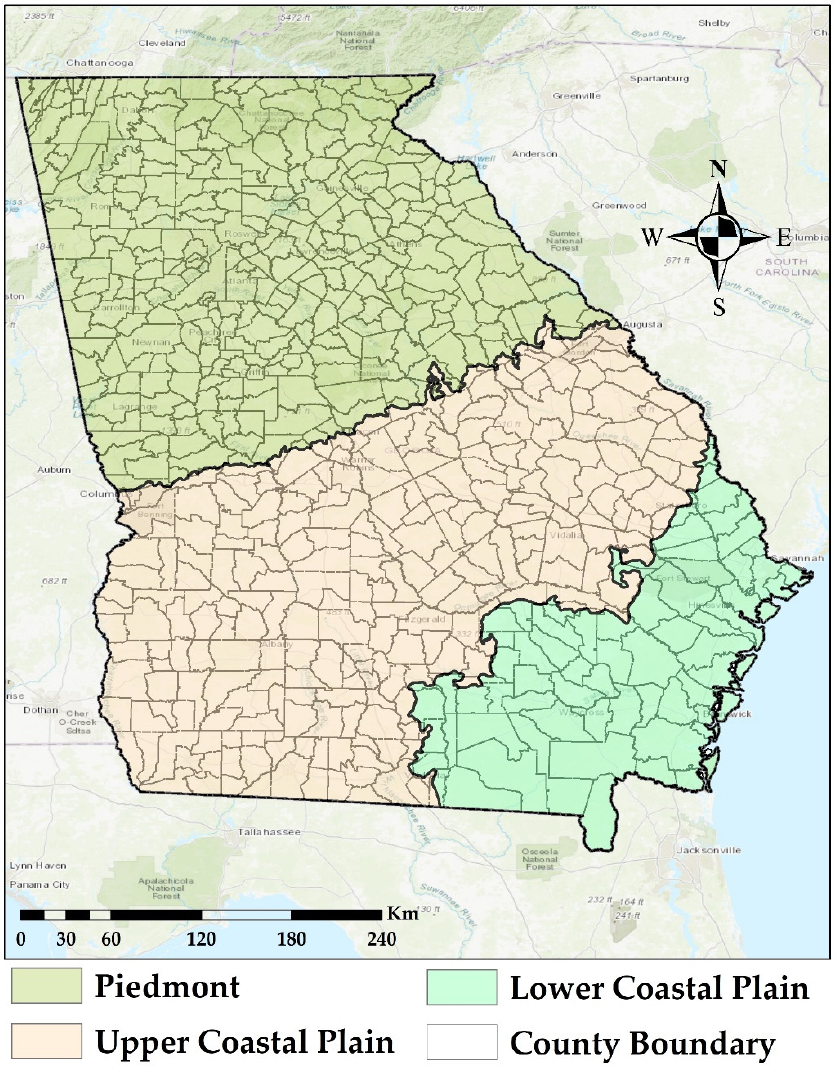
Figure 1. Major physiographic regions in Georgia. Table 1. Profiles of the surveyed foresters and respondents: credentials, service areas, and ways of service